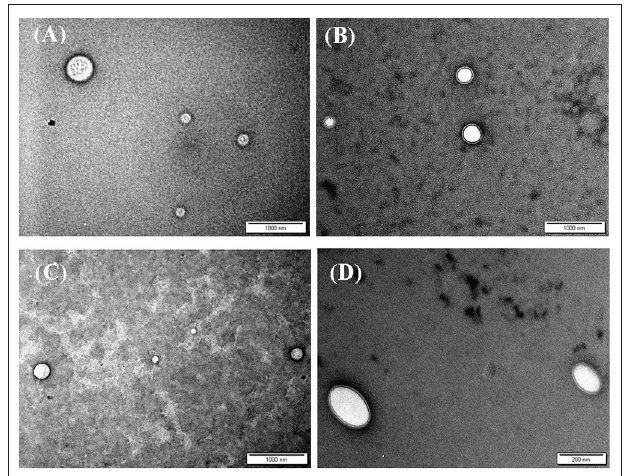
FIGURE 2 | TEM images of siRNA loaded (A) CS-LC NPs, (B) CS-LC-TPP NPs, (C) CSP-LC NPs, and (D) CSP-LC-TPP NPs. More images are shown in Supplementary Figures 2, 3 .